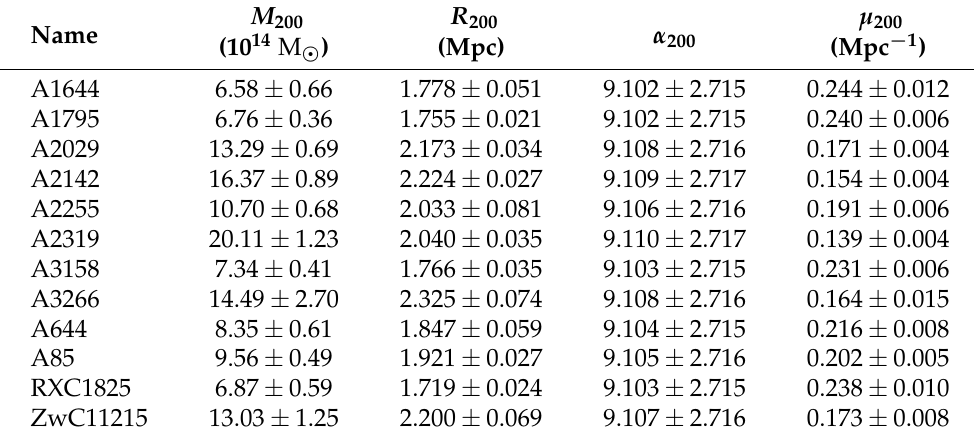
Table 1. Best fit values for α 200 and µ 200 estimated for X-COP cluster sample.